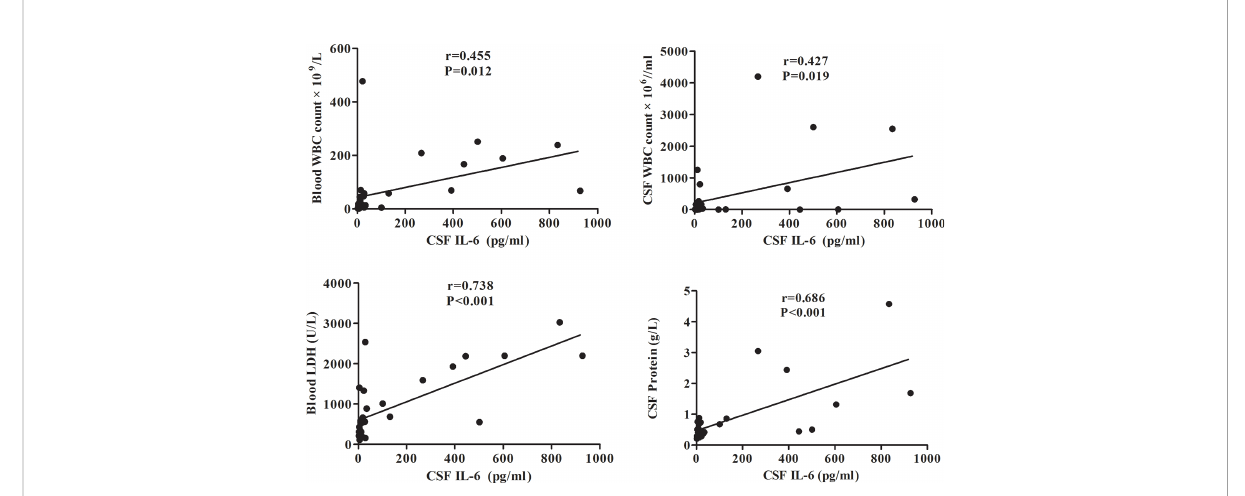
FIGURE 2 Correlation between the CSF IL-6 level and blood WBC count/CSF WBC count/blood LDH/CSF protein levels in adult AML patients. CSF, cerebrospinal fl uid; IL, interleukin; LDH, lactate dehydrogenase; AML, acute myeloid